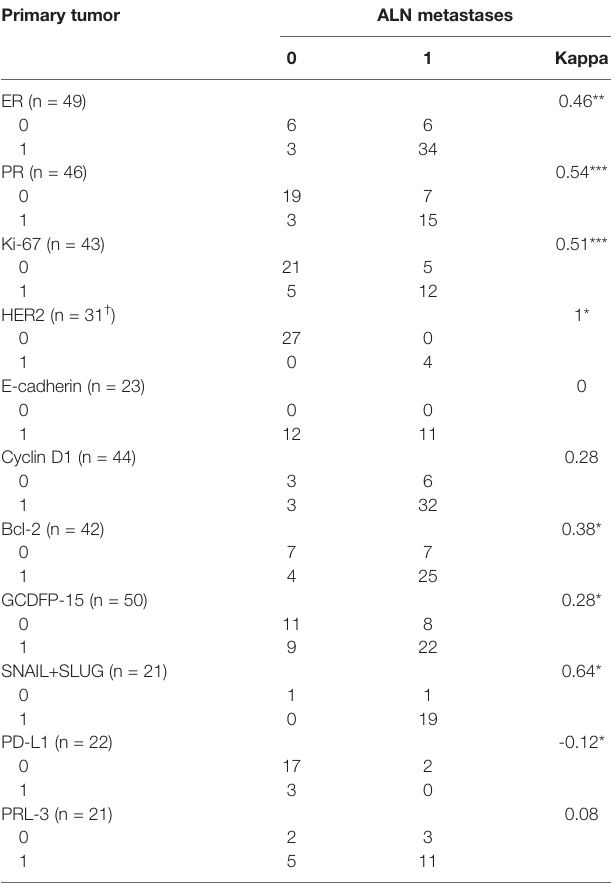
TABLE 5 | The Cohen ’ s kappa coef fi cient concordance analysis of expression status in breast PTs and synchronous ALN metastases. Primary